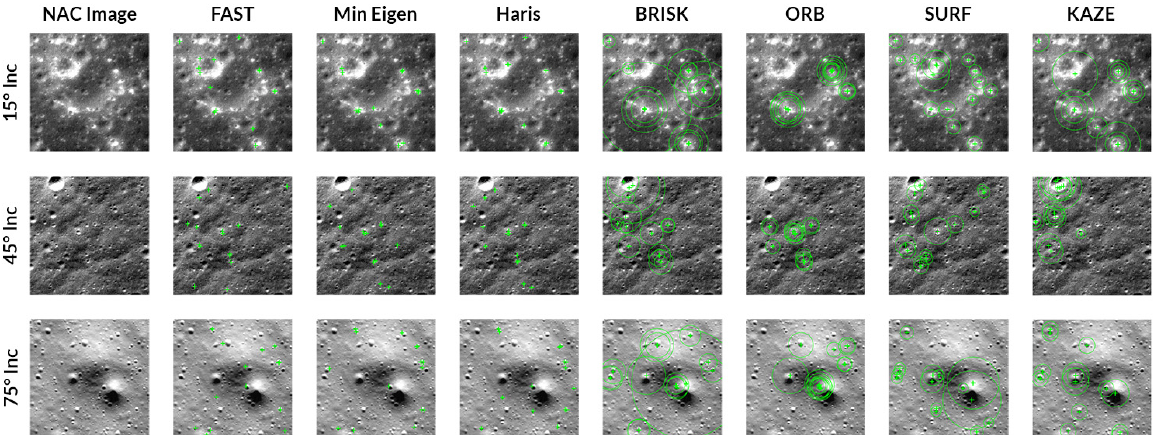
Figure 1. Application of seven feature detectors on three 256x256 pixel sub-images of LROC NAC observations with incidence angles of 15° (M109753063L), 45° (M139396321R), and 75°